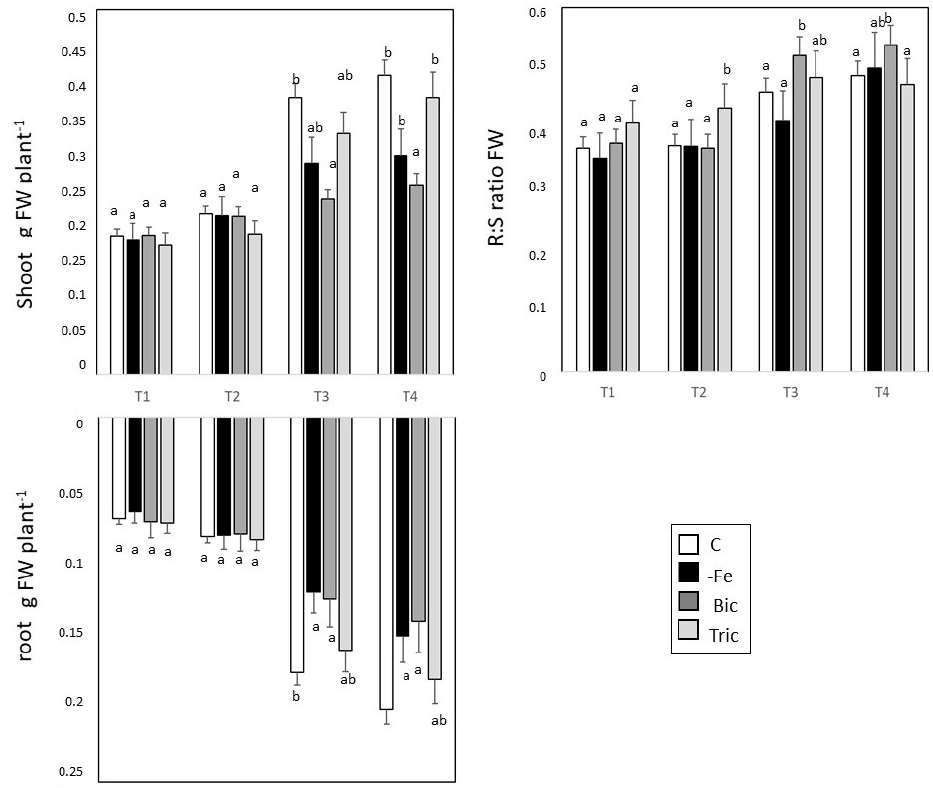
Figure 1. Determination of fresh weight (FW) of shoots and roots and root-to-shoot (R/S) ratio of plants grown in control condition (C), direct Fe deficiency conditions (–Fe), and under induced Fe deficiency in the presence of bicarbonate (Bic) or alkaline organic buffer (Tric). T1, T2, T3, and T4 correspond to sampling at 1, 3, 5, and 7 days. The R/S ratio was calculated on a FW basis. Bars indicate the means ± SE (standard error) ( n = 9). Different letters indicate statistical differences ( p < 0.05) within each treatment.